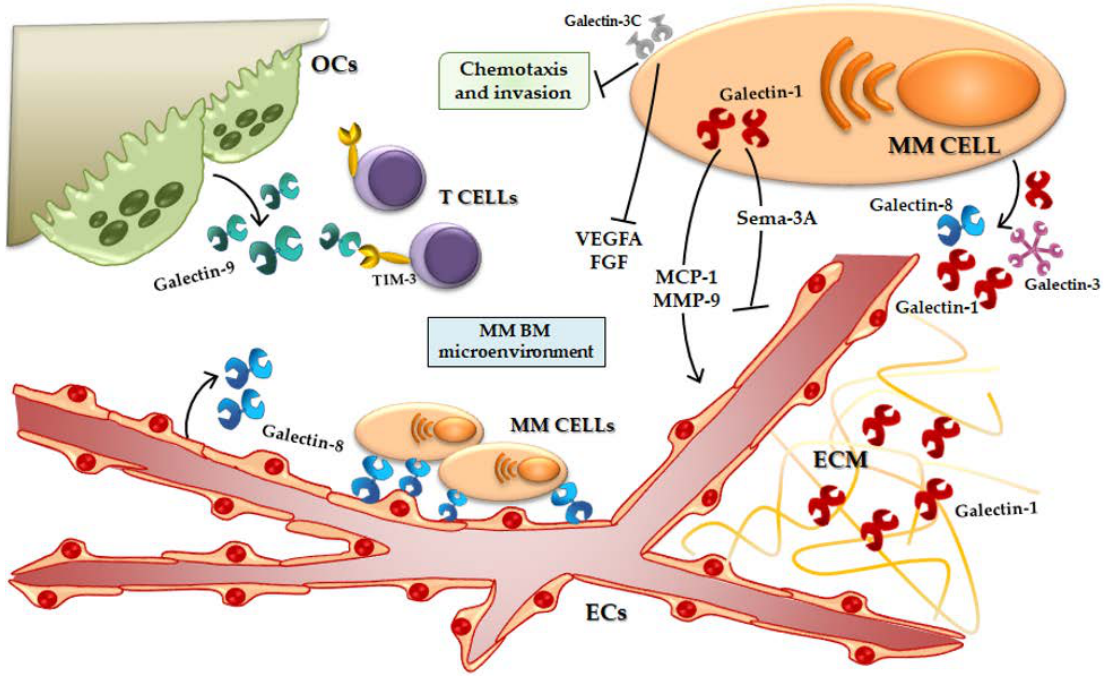
Figure 2. Galectins in the MM BM microenvironment. Galectin-1 induces the secretion of pro-angiogenic molecules and inhibits the production of anti-angiogenic ones. Galectin-1 is present in the ECM of MM patients. Galectin-3C reduces MM cell chemotaxis and invasion and the secretion of pro-angiogenic proteins. Galectin-8 is produced by ECs and mediates the adhesion between MM PCs and ECs. Galectin-9 is secreted by OCs and could mediate the T cell activity inhibition. OCs, Osteoclasts; TIM-3, T-cell immunoglobulin and mucin-domain containing-3; MM, multiple myeloma; VEGFA, Vascular endothelial growth factor A; FGF, Fibroblast growth factor; MCP-1, Monocyte chemoattractant protein-1; MMP-9, Metalloprotease-9; Sema-3A, Semaphorin -3A; ECM, Extracellular matrix; ECs, Endothelial cells; BM, bone marrow.